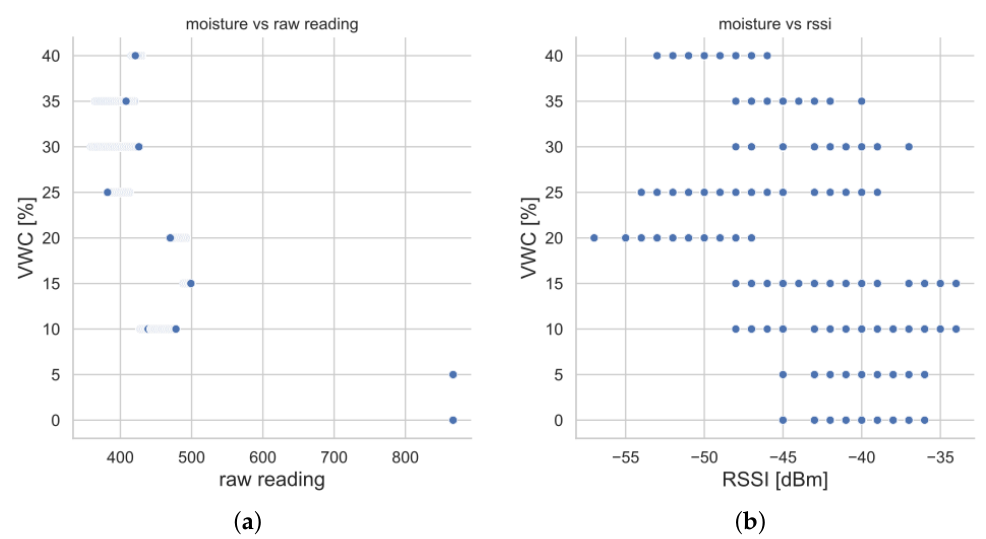
Figure 7. Experimental relationship: ( a ) between collected measured values from the sensor (i.e., “raw reading”) and reference VWCs (i.e., “VWC”), ( b ) between RSSI and reference VWCs (i.e.,